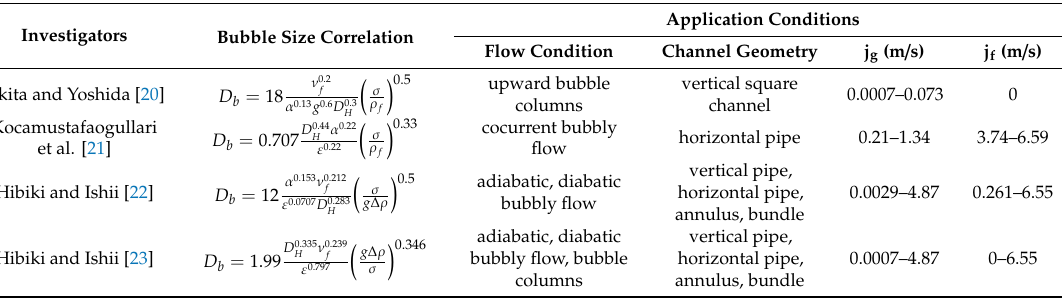
Table 1. Existing one group bubble size correlations for the gas-liquid